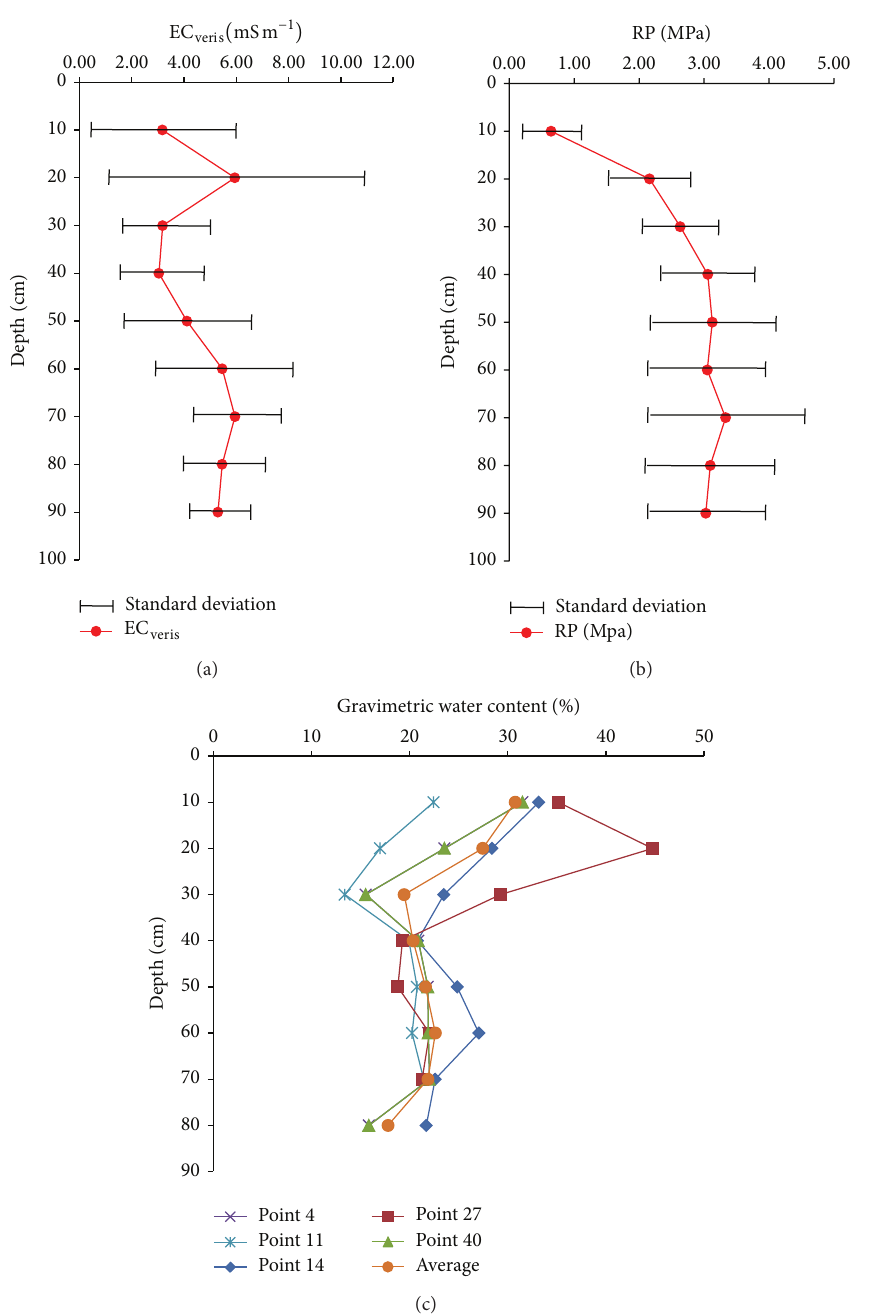
Figure 2: Mean values of EC measured continuously, penetration resistance (PR) measured at 40 points, and gravimetric water content veris at five selected